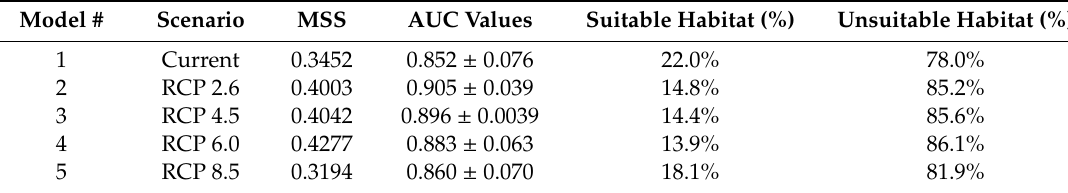
Table 7. The maximum test sensitivity plus specificity threshold (MSS) and model area under the curve (AUC) values with standard deviation for Current conditions and four future Representative Concentration Pathway (RCP) scenarios. Including the percentage of suitable and unsuitable habitat based on the MSS threshold.